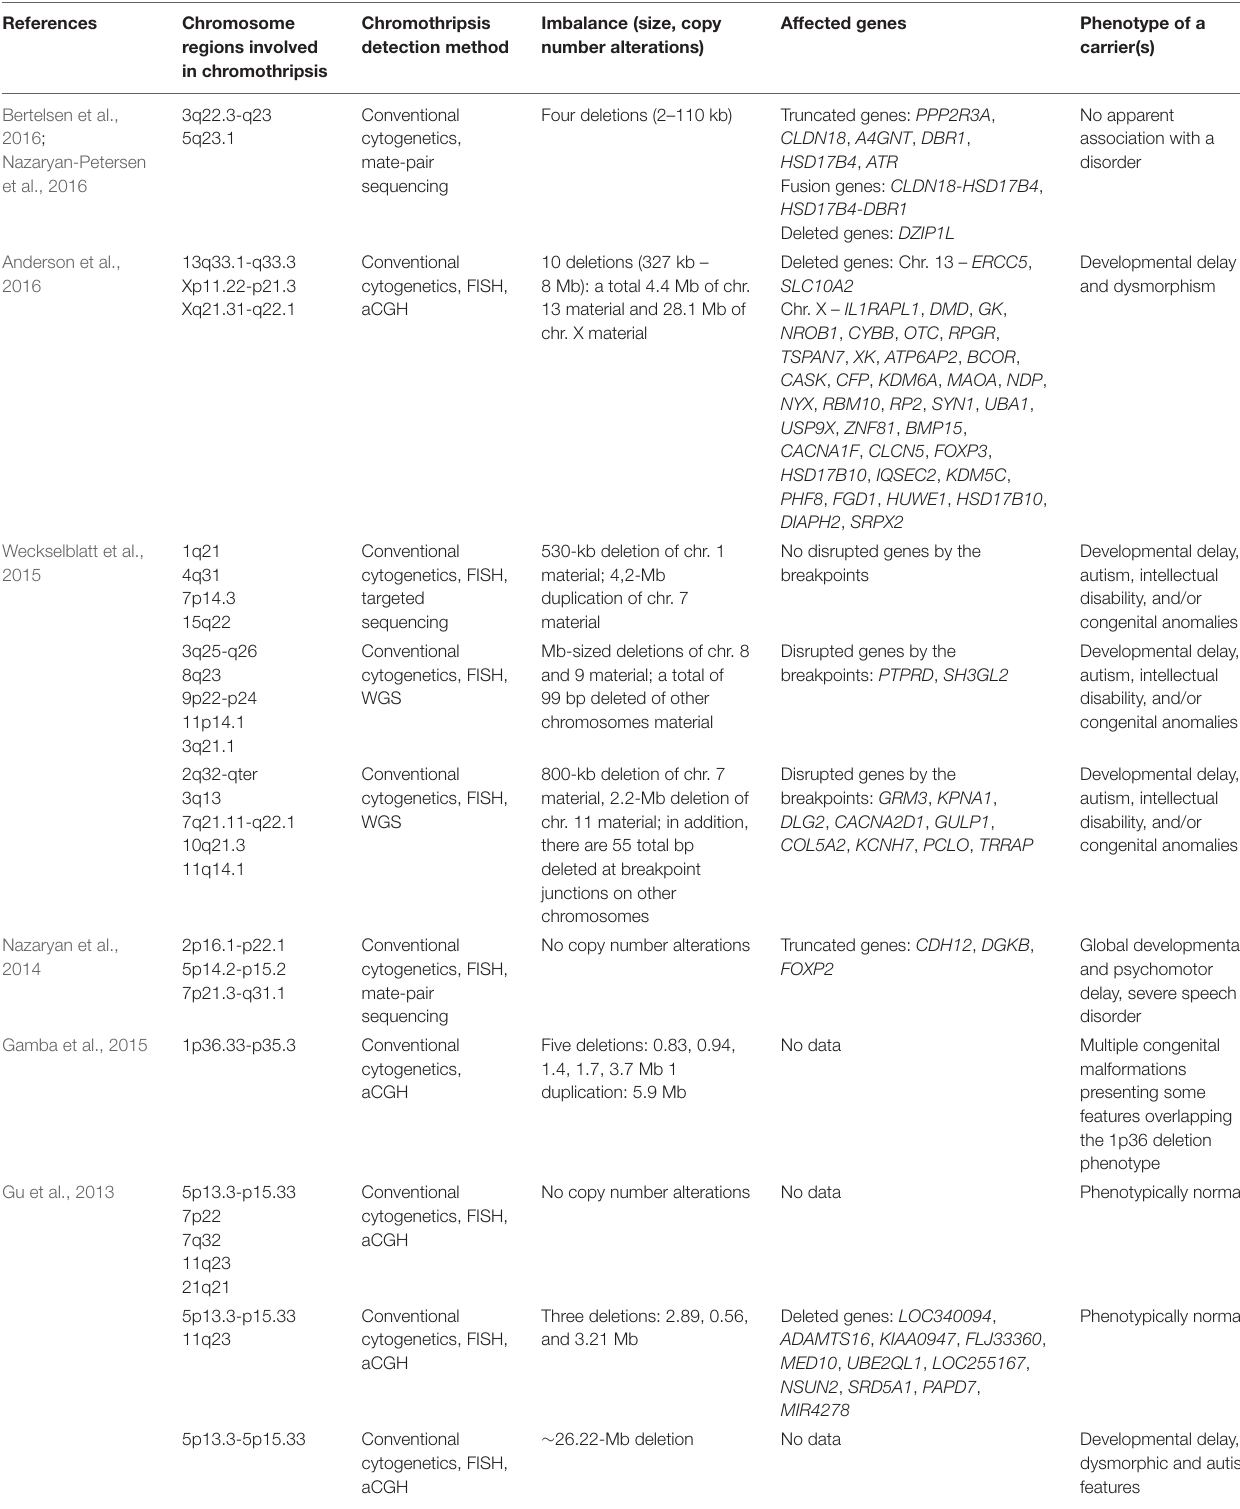
TABLE 2 | Clinical outcomes of constitutional